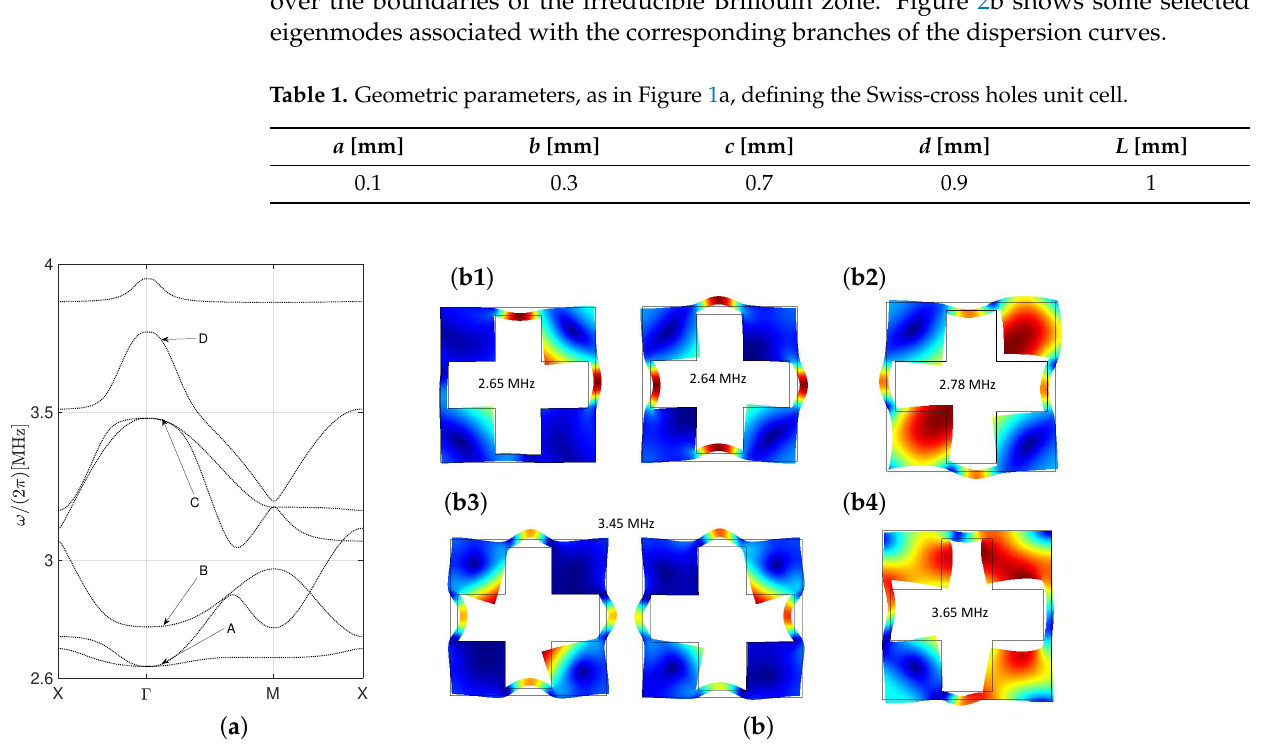
Figure 2. ( a ) Dispersion diagram of the unit cell in Figure 1a along the irreducible Brillouin zone path X Γ MX of Figure 1b. ( b ) Selected Bloch–Floquet eigenmodes associated with the wave vector located one tenth along the length of the branch Γ M, see Figure 1b, for several frequencies in the range 2.65 MHz to 3.65 MHz. Figures ( b1 ) to ( b4 ) correspond to the frequencies labelled A to D in panel ( a